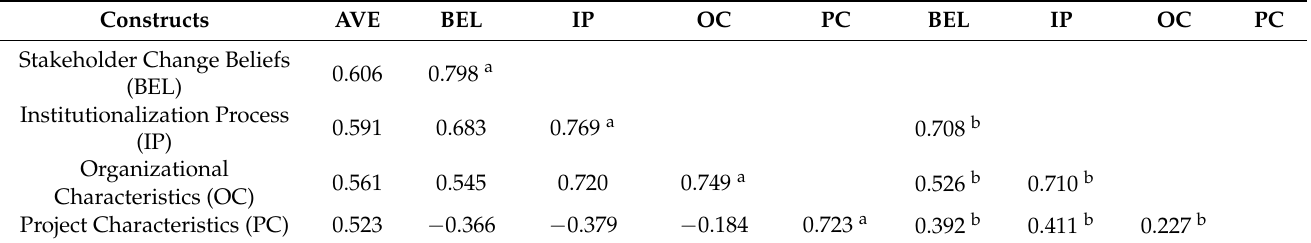
Table 2. Latent variable correlations (left) and HTMT ratios